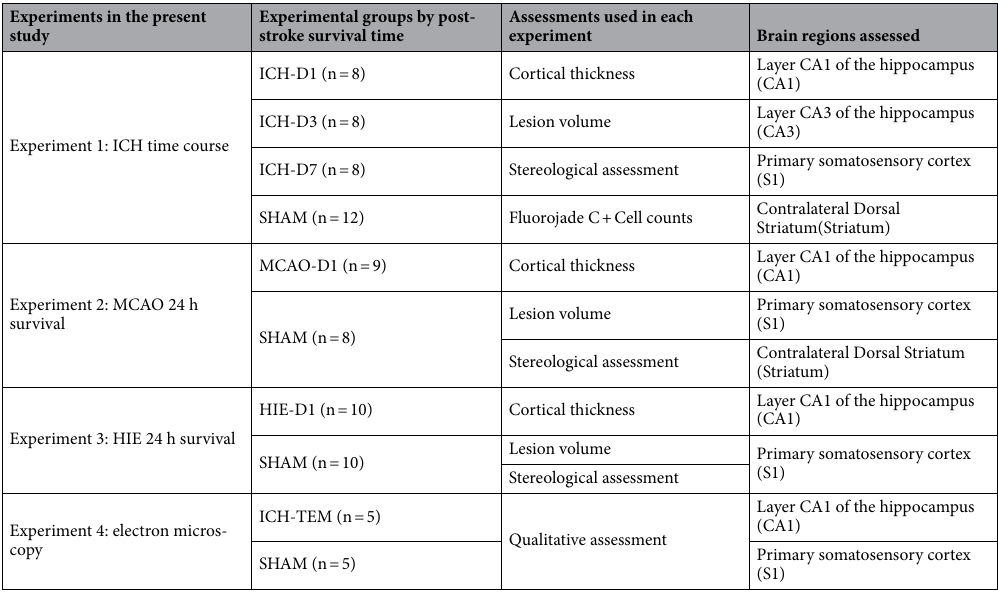
Table. 1. Timelines for Experiments 1–4. A total of 82 rats were used in this